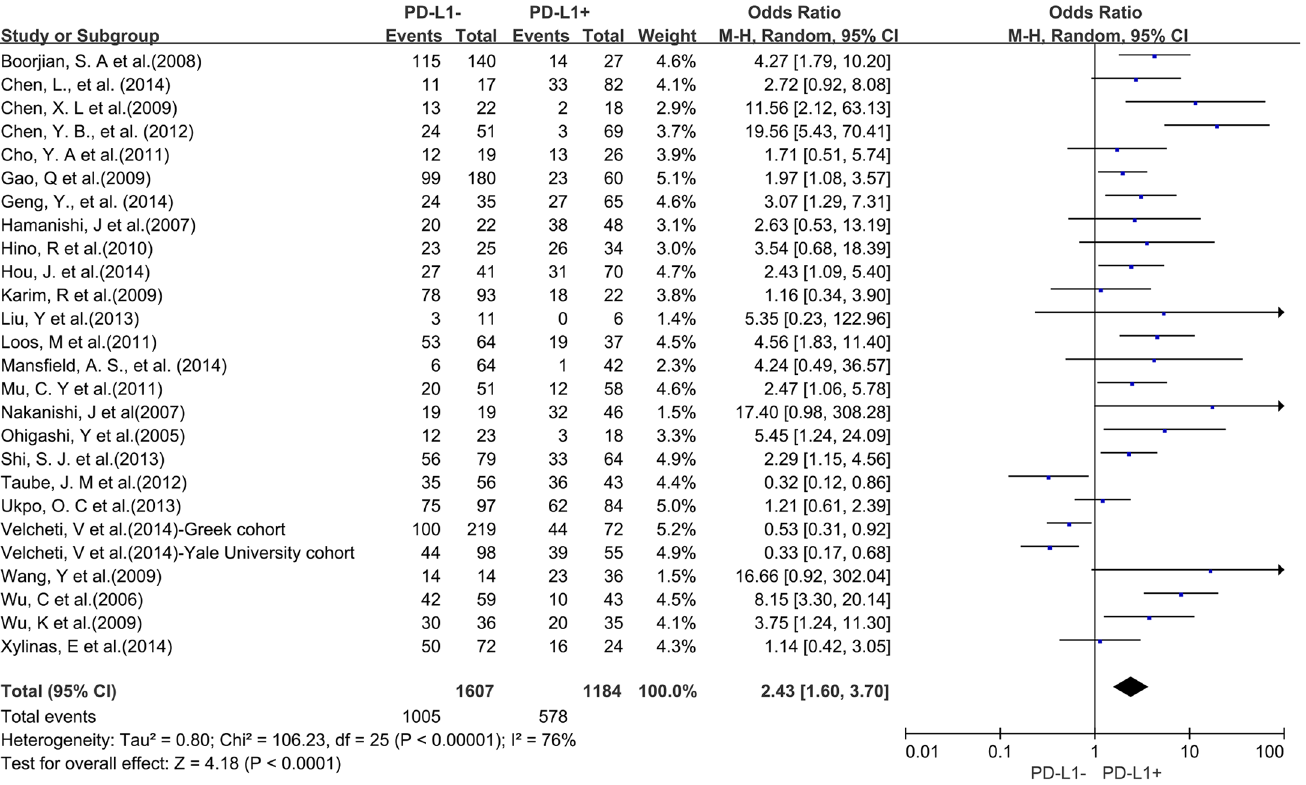
Fig 2. Forest plot describing the association between PD-L1 expression and 3-year OS of all patients with solid tumors.